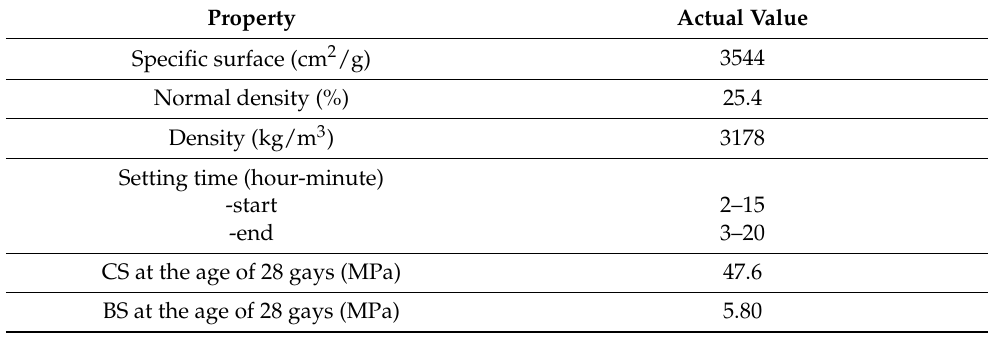
Table 1. Characteristics of Portland cement CEM I 42.5N.